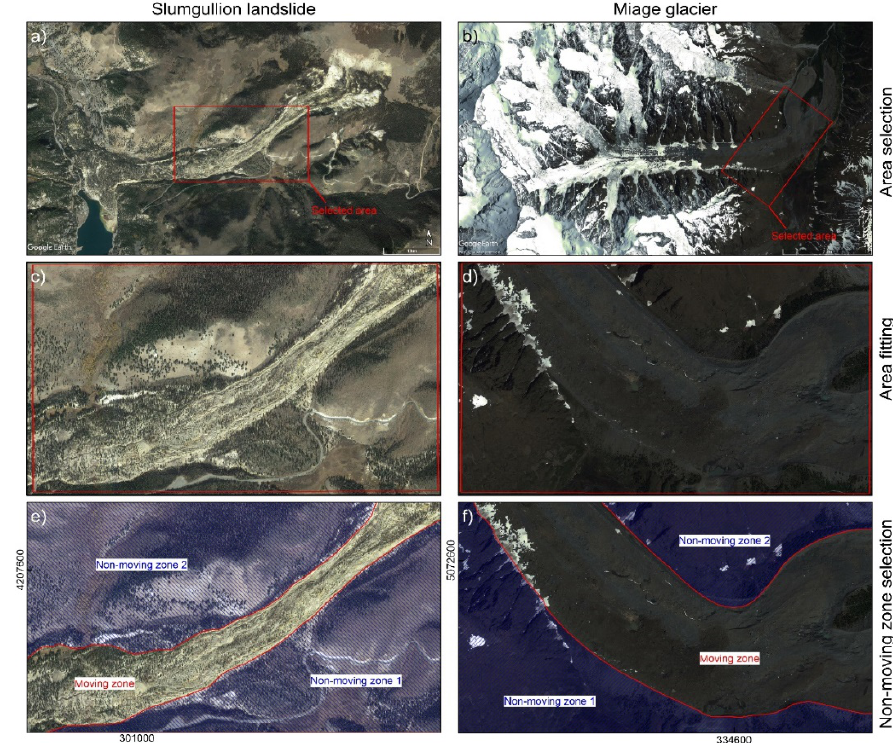
Figure 3. Selection scheme of Google Earth images and moving and non-moving zone identification: ( a , b ) study areas identification; ( c , d ) image fitting; ( e , f ) moving and non-moving zone identification. Acquisition dates are June 6, 2013 for the images depicted in ( a , c , e ) and 29 August 2009 for the images depicted in ( b , d , f ). Map data 2020 © Maxar